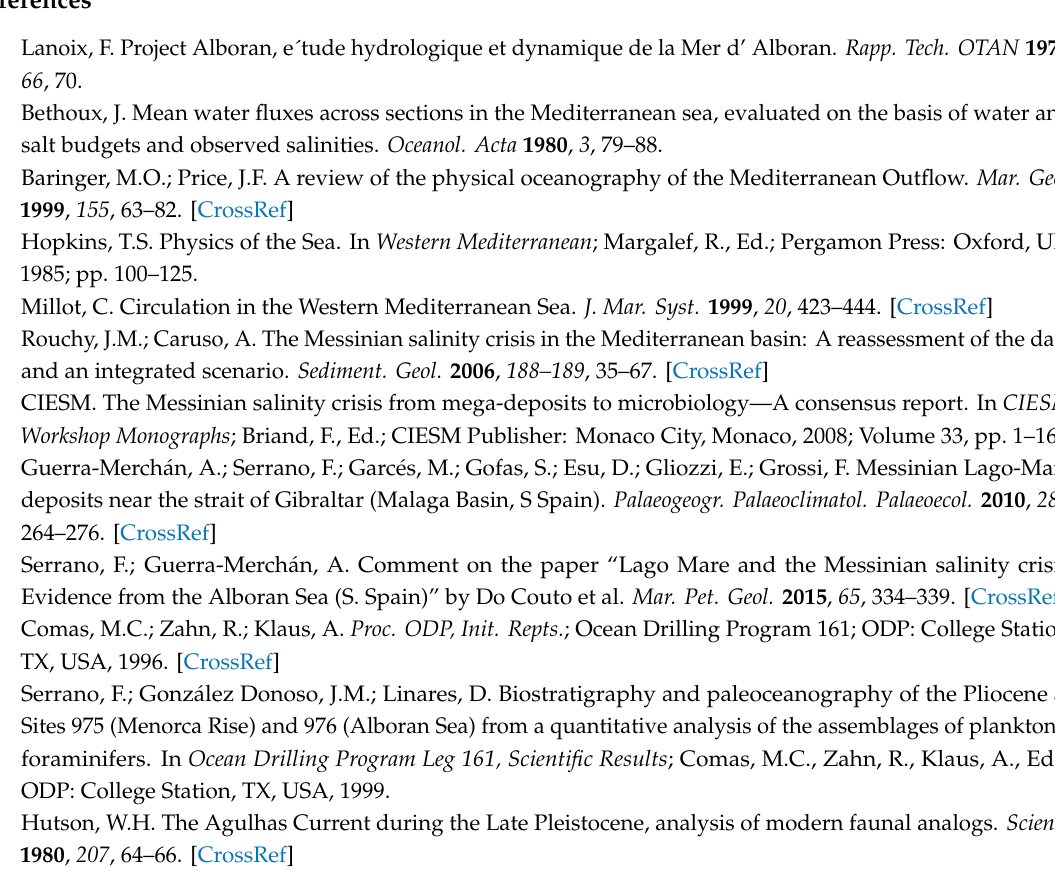
Table S1: Census of the taxa in the Pliocene-Gelasian sedimernts of the ODP-site 975, Table S2: Estimates parametres and location of the modern